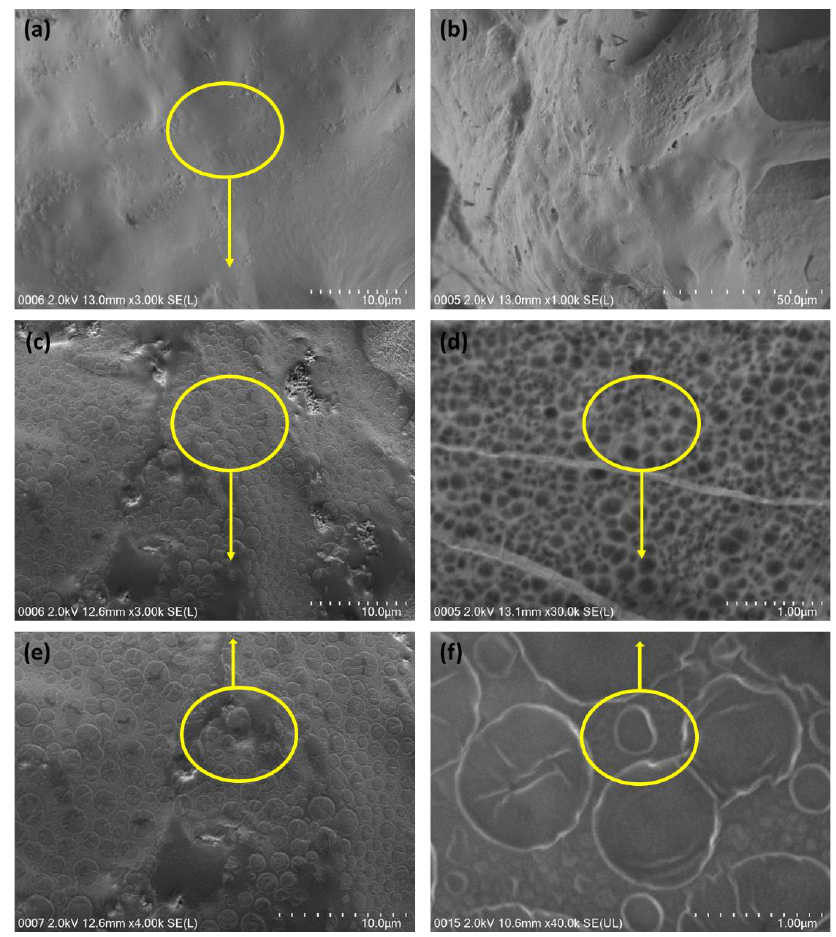
Figure 2. ( a , b ) SEM images of the alginate hydrogel and ( c , d ) the alginate/PEDOT:PSS hydrogel electrolyte at ( e ) low and ( f ) high